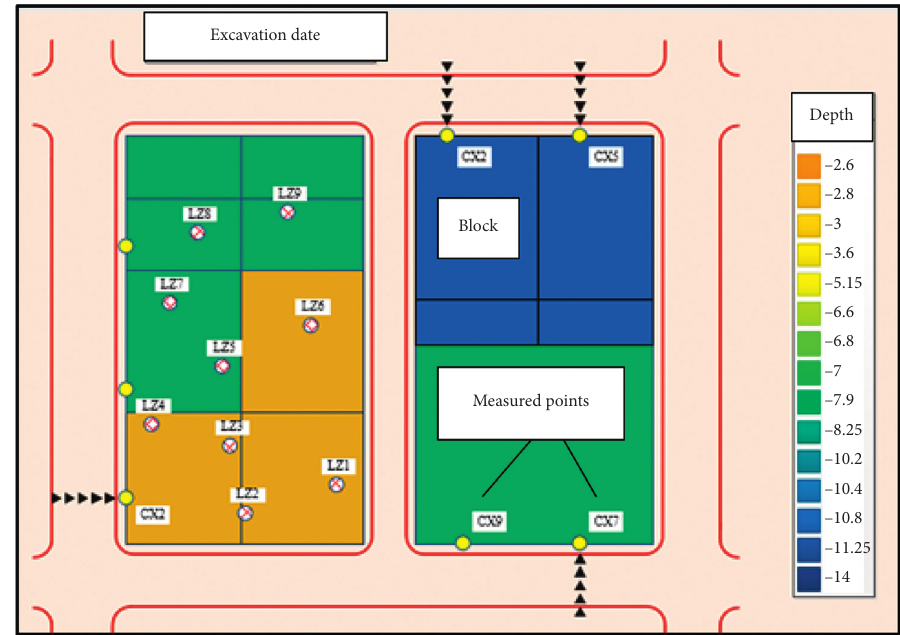
Figure 4: Visio plug-in for visualized simulation of excavation and instrumentations layout.